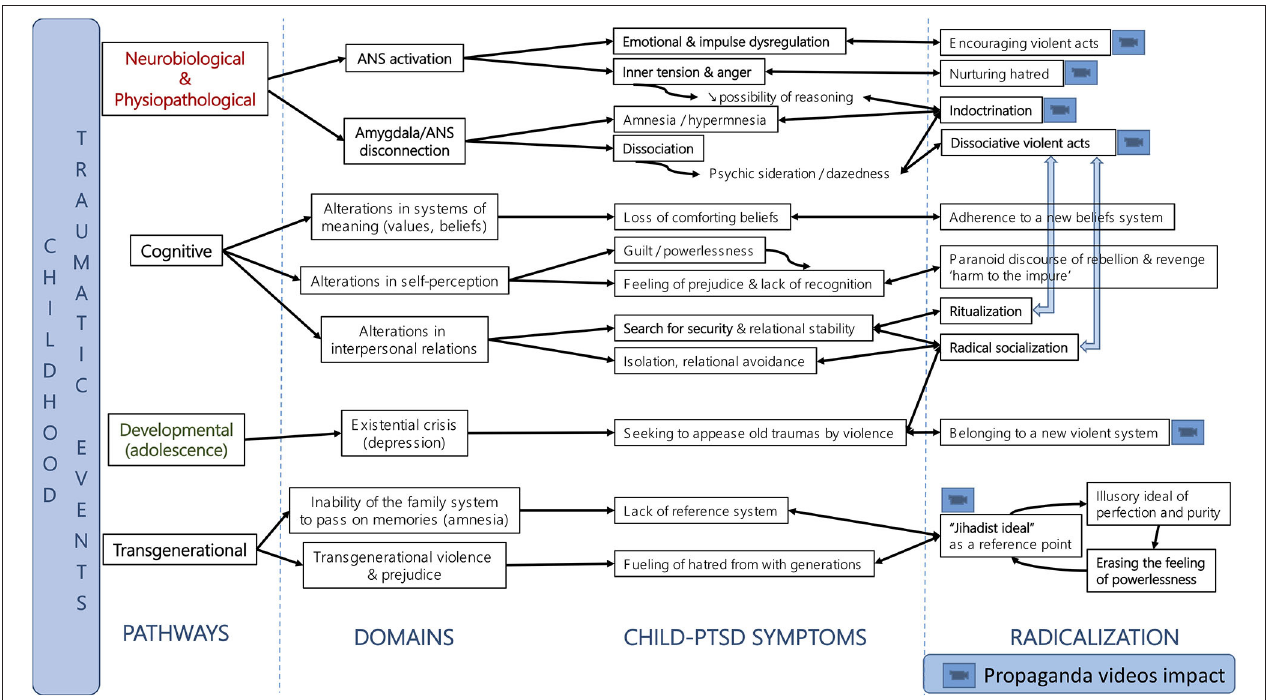
FIGURE 1 | Summarizing the hypothesis of activation of post-traumatic mechanisms in radicalized